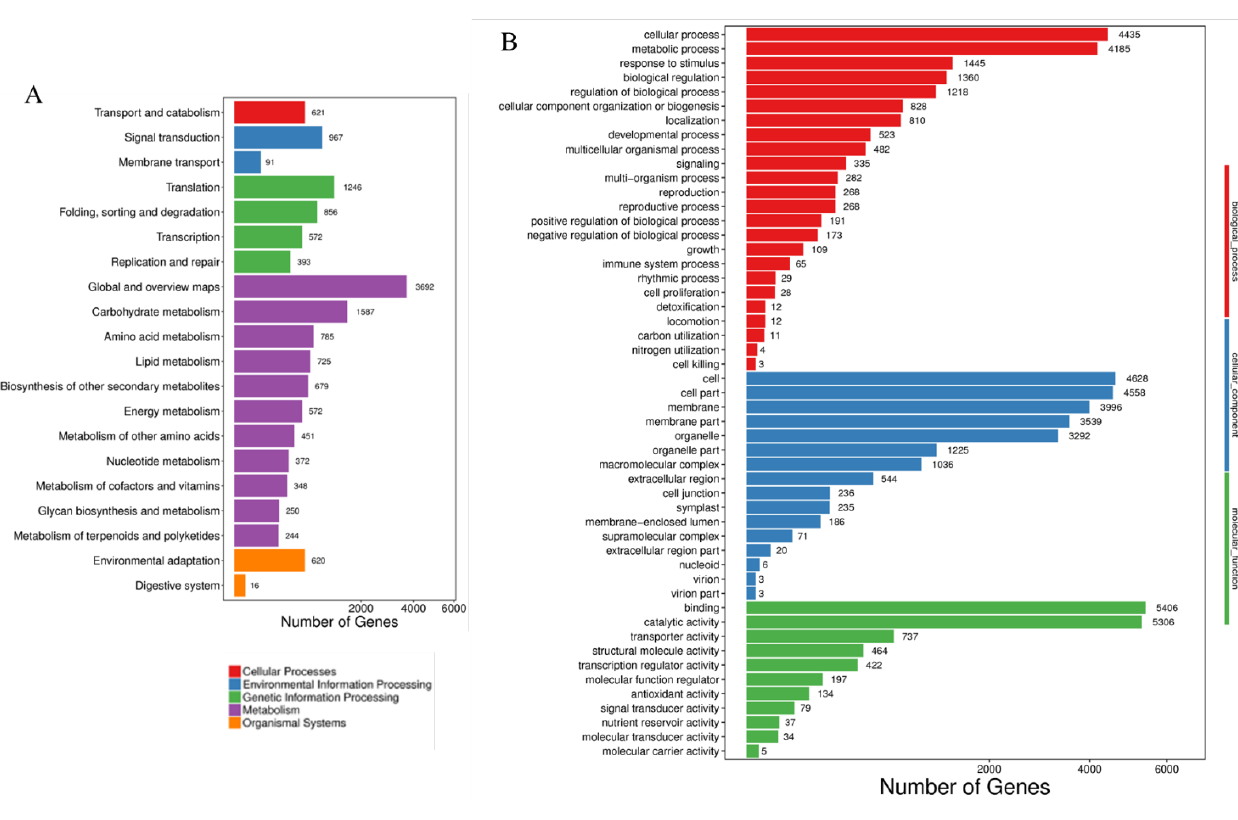
Figure 6. Classification of B. napus hypoxia stress responsive genes for each KEGG category. ( A ) Kyoto Encyclopedia of Genes and Genomes (KEGG) pathway enrichment of DEGs in B. napus . The x-axis shows the number of genes. ( B ) Gene ontology (GO) analyses of the DEGs. The y-axis shows the names of the GO terms, and the x-axis presents the number of genes.